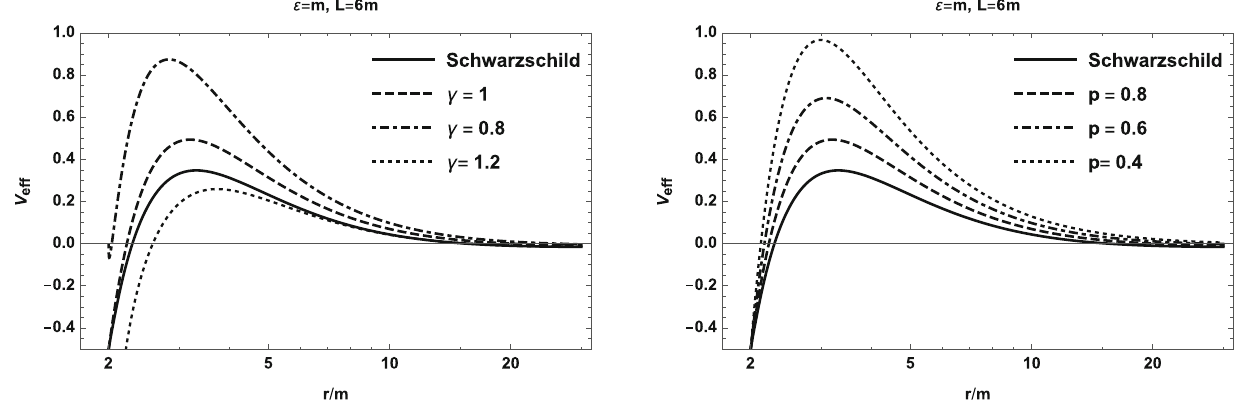
Fig. 3 The radial dependence of the effective potential V ef f ( r ) for massive test particles in the equatorial plane of the stationary ZV space- time as compared to the effective potential for Schwarzschild. In the left panel V ef f ( r ) is plotted for p = 0 . 8 and various values of γ . In the